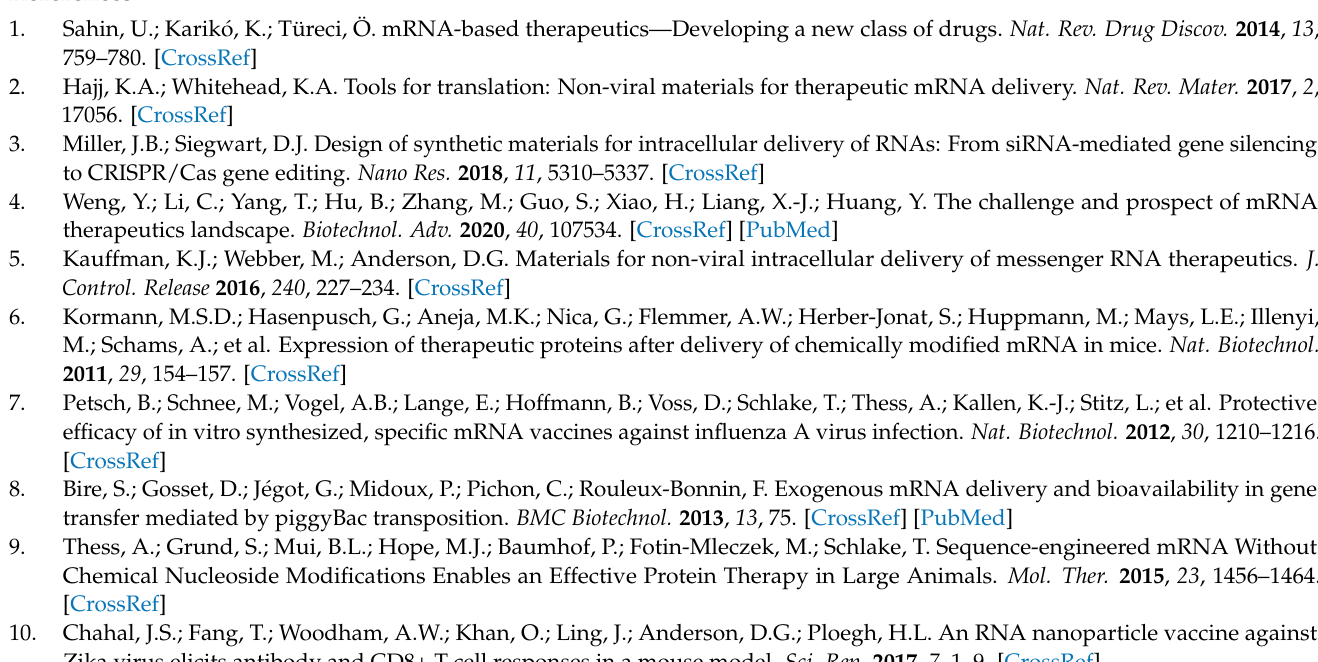
Figure S3: GPC (THF) curves of polyesters; Table S1: Raw data of in vitro screening of functional polyesters for luciferase mRNA